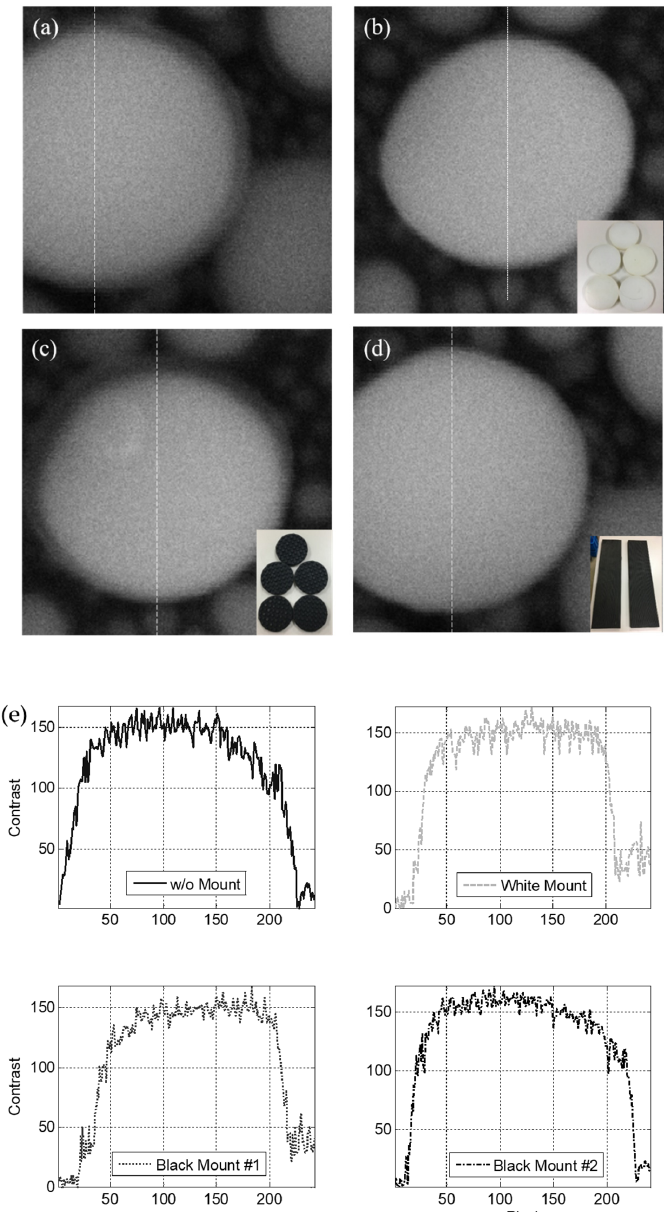
Figure 8. Specimen pattern images measured with ( a ) no mount, ( b ) white mount, ( c ) black mount #1, and ( d ) black mount #2 under operational vibration conditions; ( e ) contrast variations in the specimen pattern images.